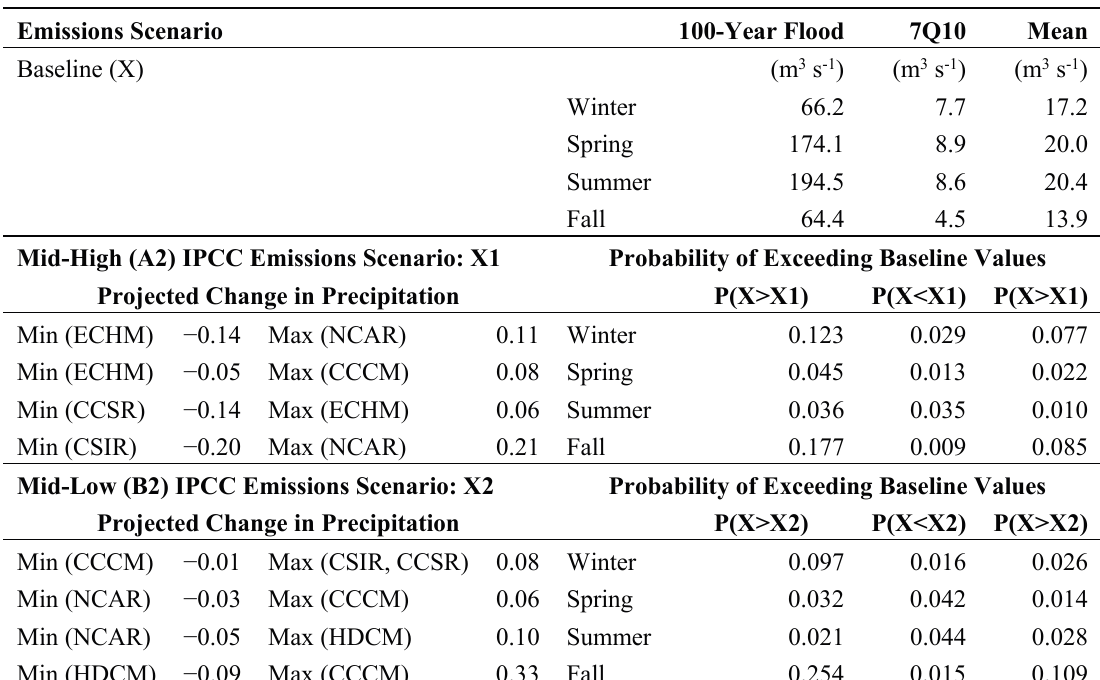
Table 4. Results from the Monte Carlo